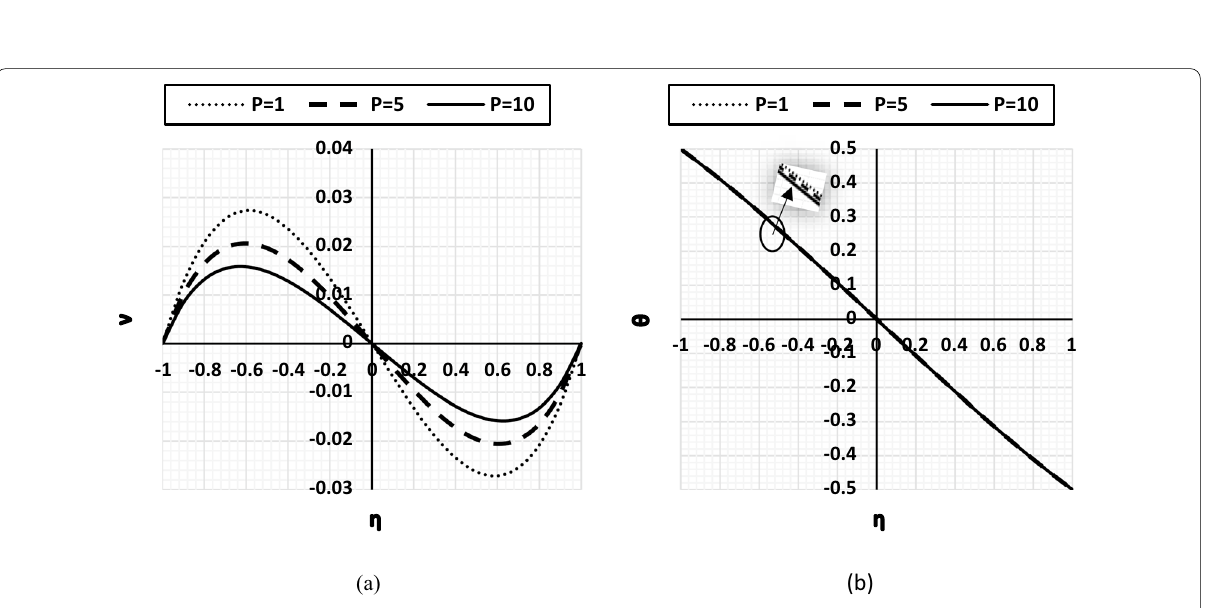
Fig. 9 Result of V ( η ) and θ ( η ) for various P when ϕ